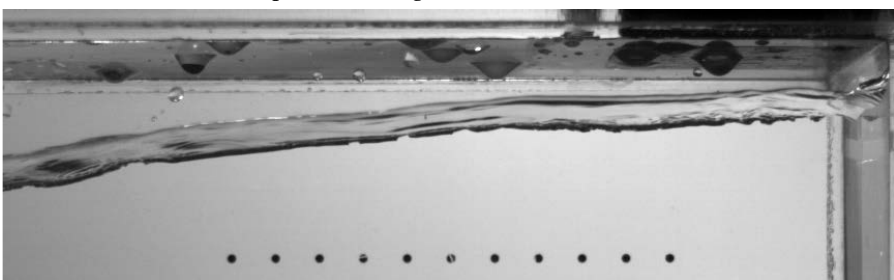
Figure 24. Droplet Location of SWAY (the 2 nd experiment).